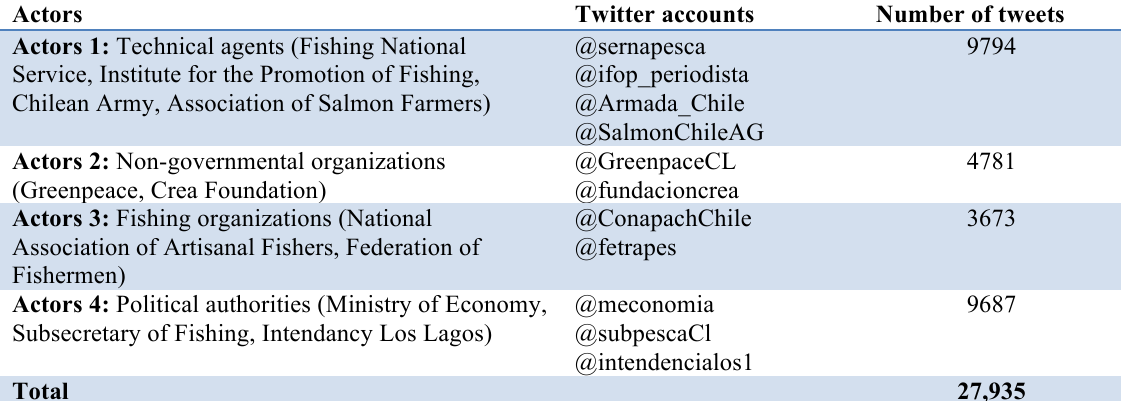
Table A1.4 Keywords for the selection of Tweets Original words in